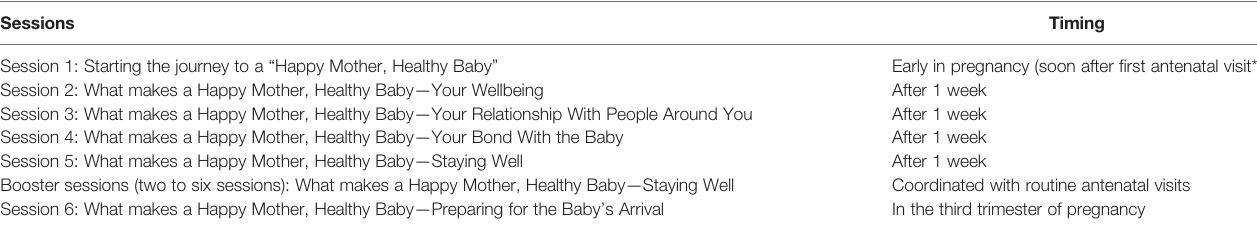
TABLE 3 | Structure of the Happy Mother, Healthy Baby. Sessions Timing Session 1: Starting the journey to a “ Happy Mother, Healthy Baby